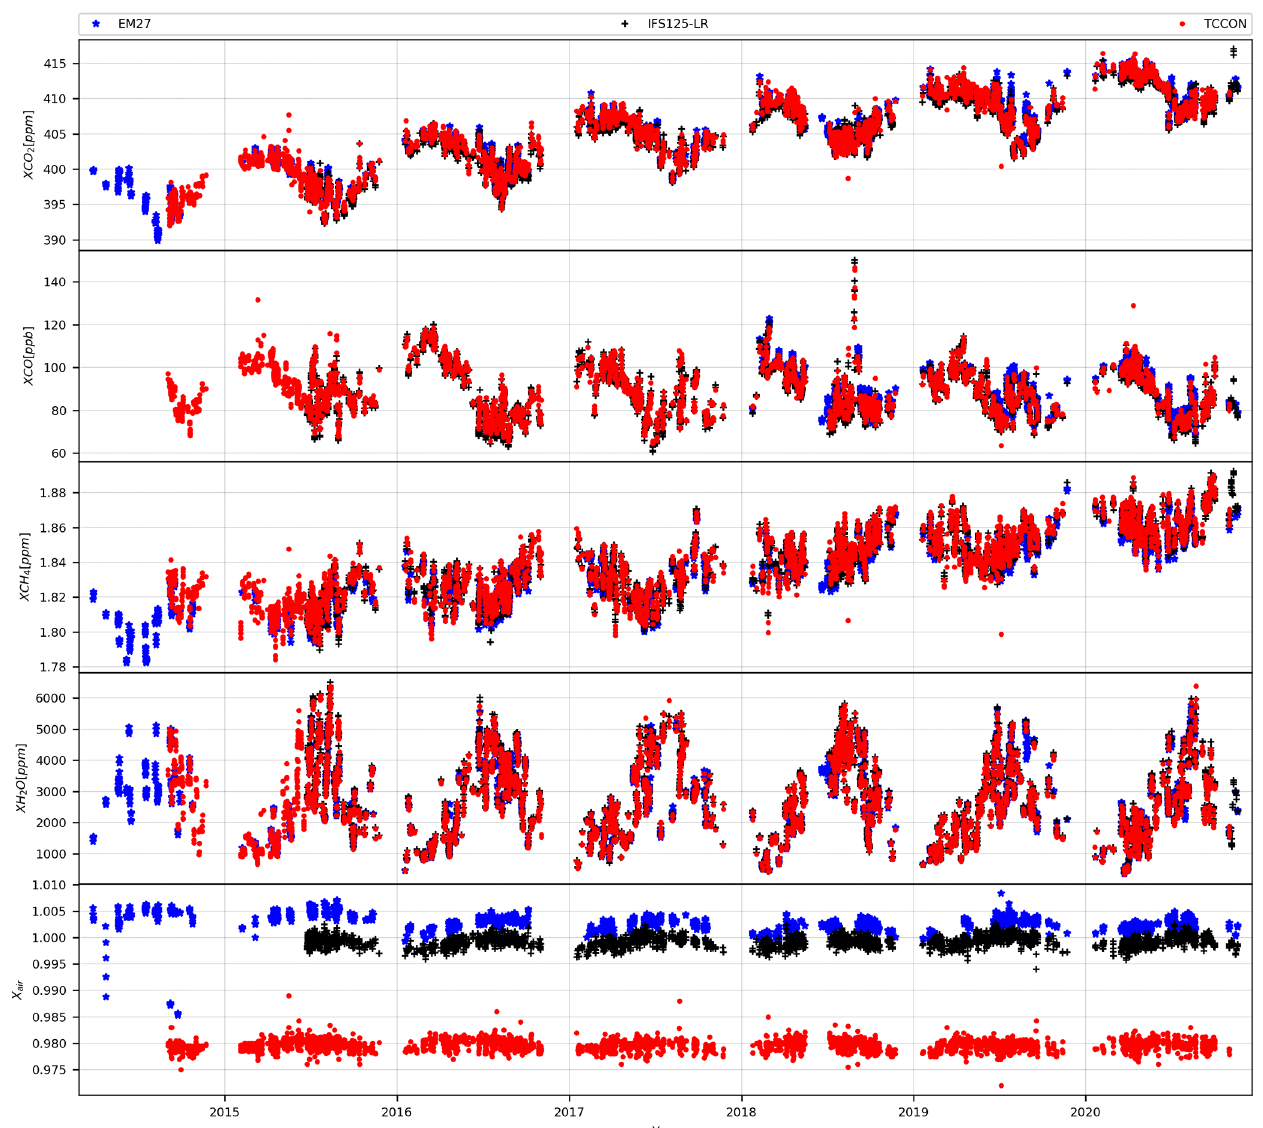
Figure 20. Time series of XCO 2 , XCO, XCH4, XH 2 O and X AIR measured with the COCCON reference instrument (blue), from the TCCON station Karlsruhe (derived from high-resolution IFS125-HR spectra using GGG2014, red) and derived from low-resolution IFS125- HR spectra (black). The low-resolution measurements were processed with